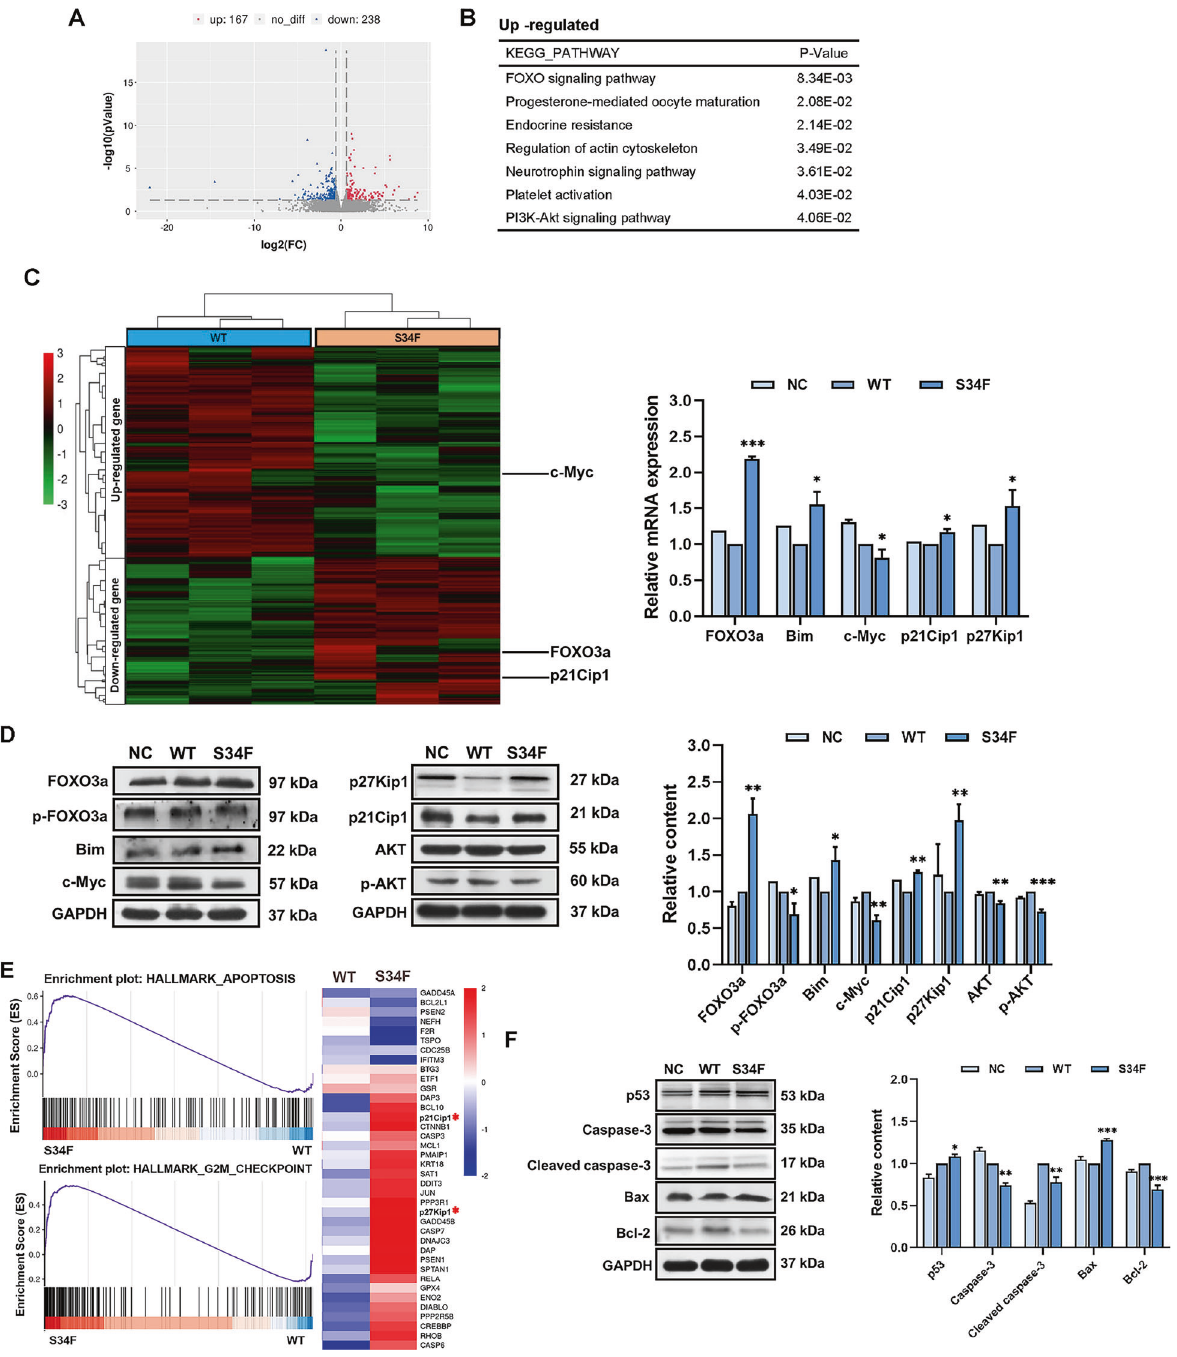
Fig. 3 S34F mutant U2AF1 affects gene expression in SKM-1 cell line. A The volcano plot indicates the distribution of DEGs based on the RNA-seq data obtained from wild-type samples as well as S34F mutant U2AF1 samples. B The pathway enrichment analysis on the upregulated DEGs of KEGG. C Hierarchical clustering plot of the fold changes (FC) of gene expressions in six samples induced by S34F mutant U2AF1 detected by RNA-seq (FC > 1.5, p -values < 0.05). The mRNA expression of FOXO3a, Bim, c-Myc, p21 Cip1 , and p27 Kip1 in SKM-1 cells treated with wild-type and S34F mutant U2AF1 by qRT-PCR. D The altered protein levels of U2AF1 S34F mutation-associated genes were validated by western blotting in SKM-1 cells. Quantitative analysis of western blotting bands from three independent experiments is shown. E Heatmap showing the enriched genes in the apoptosis pathway of GSEA results between wild-type and S34F mutant U2AF1 -treated SKM-1 cells (FDR q < 0.25). F Representative bands of western blotting data showing the protein levels of p53, Cleaved caspase-3, caspase-3, Bcl-2 as well as Bax in different groups based on the GSEA results. The data represent at least two independent experiments with three samples in each group. *p < 0.05, **p < 0.01, and *** p < 0.001. WT wild-type, NC negative